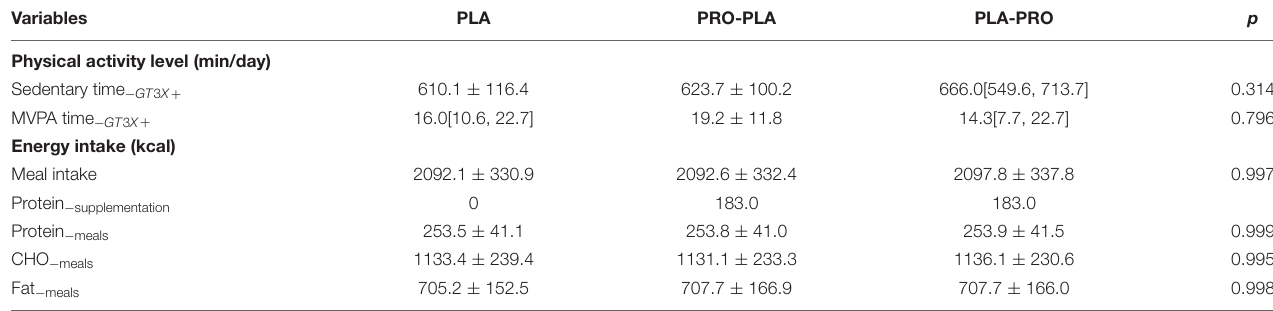
TABLE 2 | Physical activity level before each intervention and energy intake during the experimental stage. Variables PLA PRO-PLA PLA-PRO